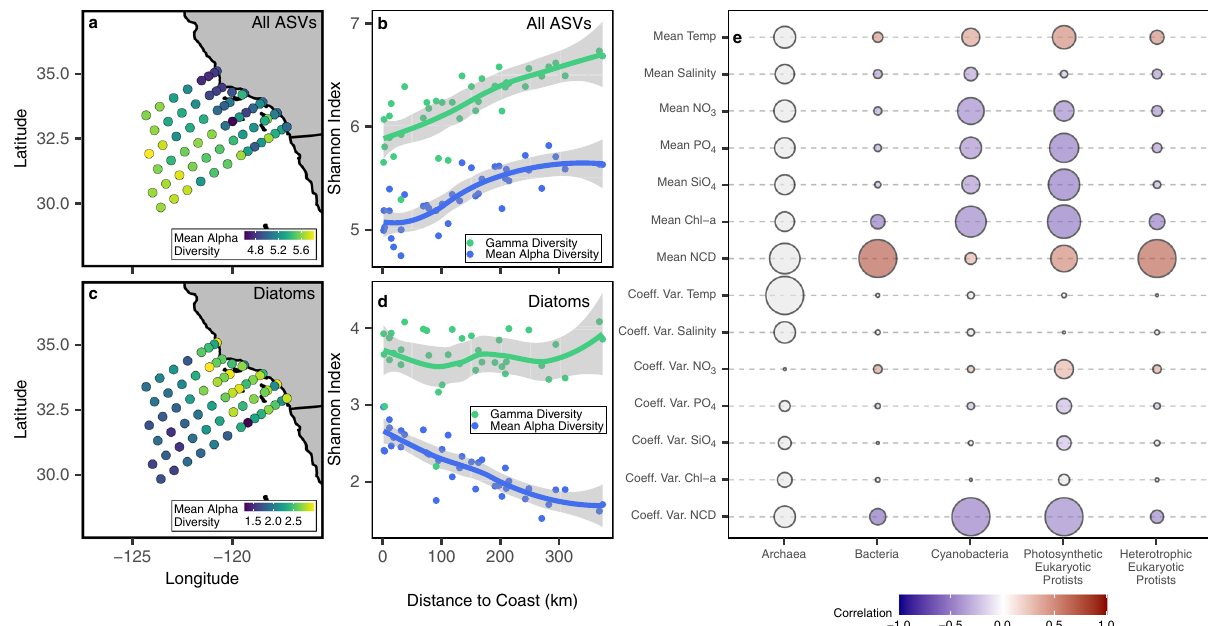
Fig. 4 Spatial patterns and drivers of diversity. a Map showing the mean alpha diversity for all ASVs for each station. b mean alpha (blue) and gamma diversity (green) per station for all ASVs as a function of distance to shore (km). Shannon index was used as the primary measure of diversity and was calculated as the mean per station per cruise for this analysis. Relationships are fi t as a generalized additive model (GAM) with a 95% con fi dence interval. c map showing the mean alpha diversity for diatoms for each station. d mean alpha (blue) and gamma diversity (green) per station for diatoms as a function of distance to shore (km). Relationships are fi t as a generalized additive model (GAM) with a 95% con fi dence interval (shading). e relative importance of all explanatory variables (mean and coef fi cient of variation) used to predict mean alpha diversity at a given station. Relationships between environmental variables and diversity were assessed via a generalized linear model with a gaussian fi t. Larger circles represent lower AIC values within a column. Circles and their associated AIC values should not be compared across columns. Color represents the correlation coef fi cient between each explanatory variable and mean alpha diversity. Gray circles represent relationships that are not signi fi cant ( p > 0.05). Relationships were analyzed between diversity and the mean and coef fi cient of variation (Coeff. Var.) of environmental variables. Environmental variables included: temperature (Temp), salinity, NO 3 , PO 4 , SiO 4 , chlorophyll a (Chl-a), and nitracline depth